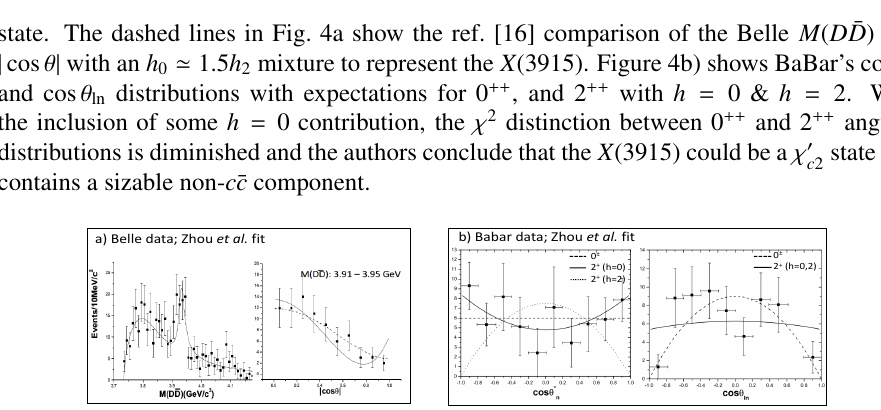
Figure 4. a) Belle M ( D ¯ D ) ( left ) and | cos θ ∗ | ( right ) distributions for γγ → D ¯ D production. The solid (dashed) curves show expectations for h solid curve for 2 ++ with h = 0 or 2, and a dashed curve for 0 ++ . (From ref.